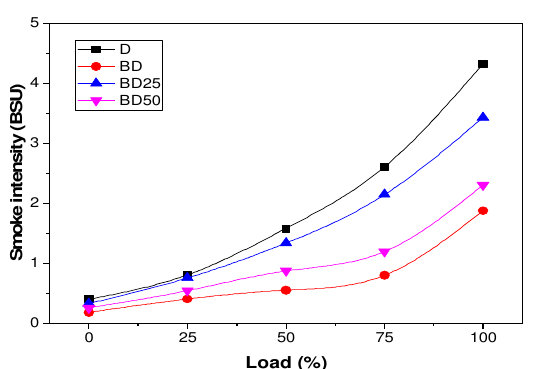
Fig. 8: Engine load variation with smoke emission with diesel and Jatropha biodiesel